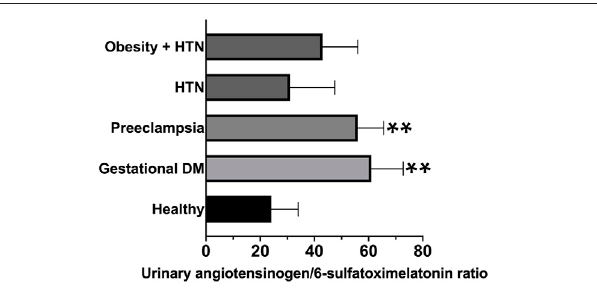
FIGURE 4 | Angiotensinogen/6-sulfatoxymelatonin ratio was calculated as (angiotensinogen/creatinine ratio, ug/g)/(6-sulfatoxymelatonin, ug/h). Graphs are ranks plots with bars of median with interquartile range; Kruskal – Wallis test **, p < 0.005 in comparison to the healthy group.